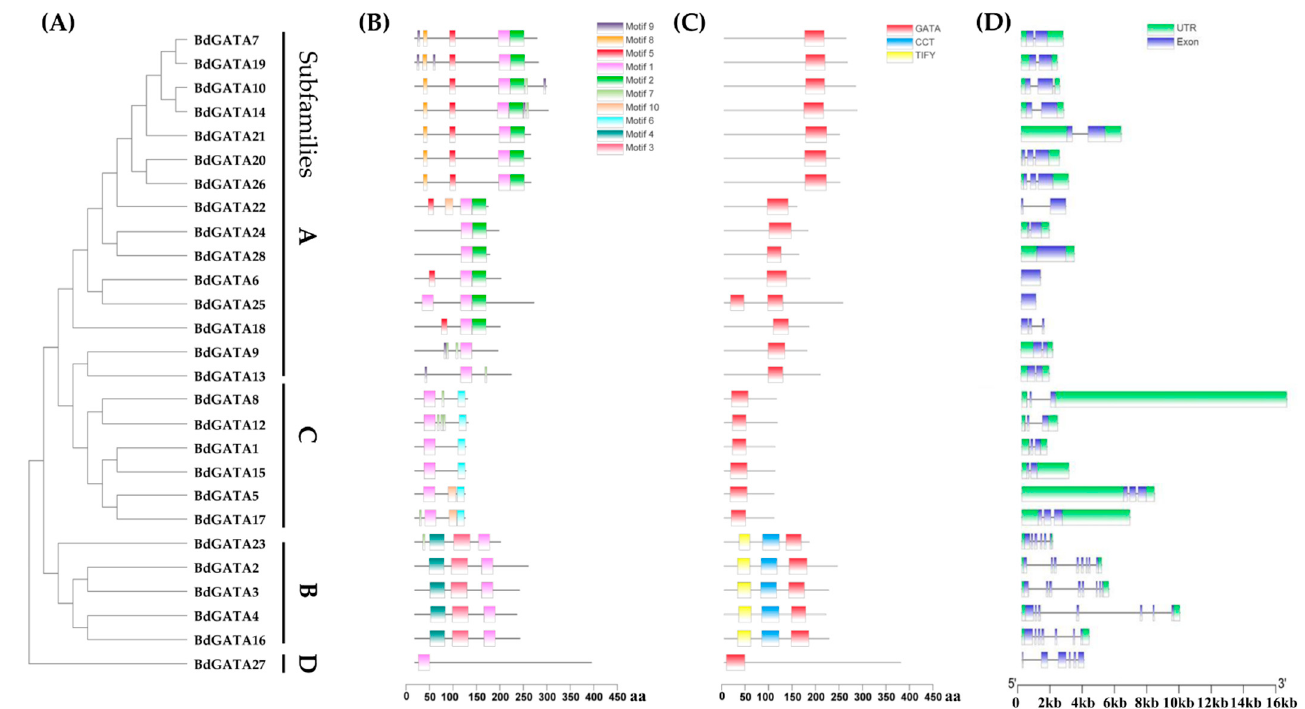
Figure 4. Putative conserved motifs, domains, and gene structures of the BdGATA family. ( A ) Phylogenetic tree. Multiple sequence alignment of BdGATA proteins was performed using ClustalX. The neighbor-joining tree was constructed using MEGA v5.0 with 1000 bootstrap replicates. ( B ) Conserved motifs. MEME Suite version 5.1.1 revealed the conserved motifs of the GATA proteins. ( C ) The distribution of conserved domains of BdGATA family. aa: amino acids. ( D ) Gene structure. The blue square, green square, and black lines represent the exon, untranslated region (UTR), and intron, respectively.